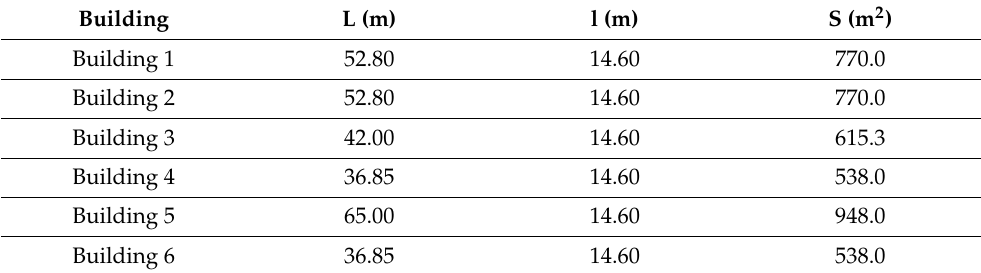
Table 2. Geometrical dimensions of the buildings of the examined industrial area.